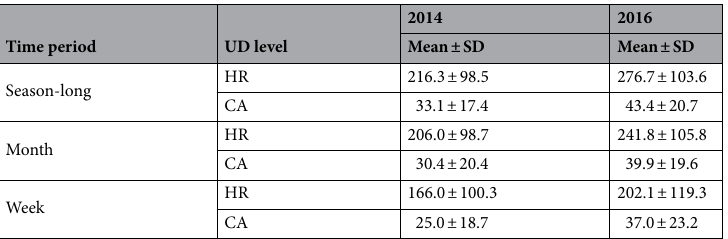
the active waste cells (Supplementary Fig. S4a.i, a.ii) and decreased for sows with UDs that included a greater percentage of the landfill (Supplementary Fig. S5a.i, a.ii). The top season-long 2D overlap model included interactions among UD level, landfill, and sow covariates (Supplementary Table S6). Overall, season-long 2D overlap increased for sows with UDs that were closer to the waste cells (Fig. 3e) and for sows with UDs that included a greater percentage of the landfill (Fig. 3b). At the home range level, season-long 2D overlap decreased for older sows but increased for heavier sows (Table 2). The top monthly 2D overlap model included interactions between UD level and landfill covariates (Supplementary Table S7). Monthly 2D overlap increased for sows with UDs that were closer to the waste cells (Supplementary Fig. S4b.i) and for sows with home-ranges that included a greater percentage of the landfill (Supplementary Fig. S5b.i; Table 2). The top weekly 2D overlap model included interactions among UD level, landfill, sow, cover type, and weather covariates (Supplementary Table S8). Overall, weekly 2D overlap increased for sows with UDs that were closer to the waste cells (Supplementary Fig. S4b.ii), that included a greater percentage of the landfill (Supplementary Fig. S5b.ii), for heavier sows, and for sub-adult sows (Table 2). Top season-long, monthly, and weekly VI models included interactions among UD level, landfill, sow, and vegetation cover type covariates (Supplementary Tables S9-11). Season-long, monthly, and weekly VI increased for sows with home ranges that were closer to the waste cells and decreased for sows with home ranges that